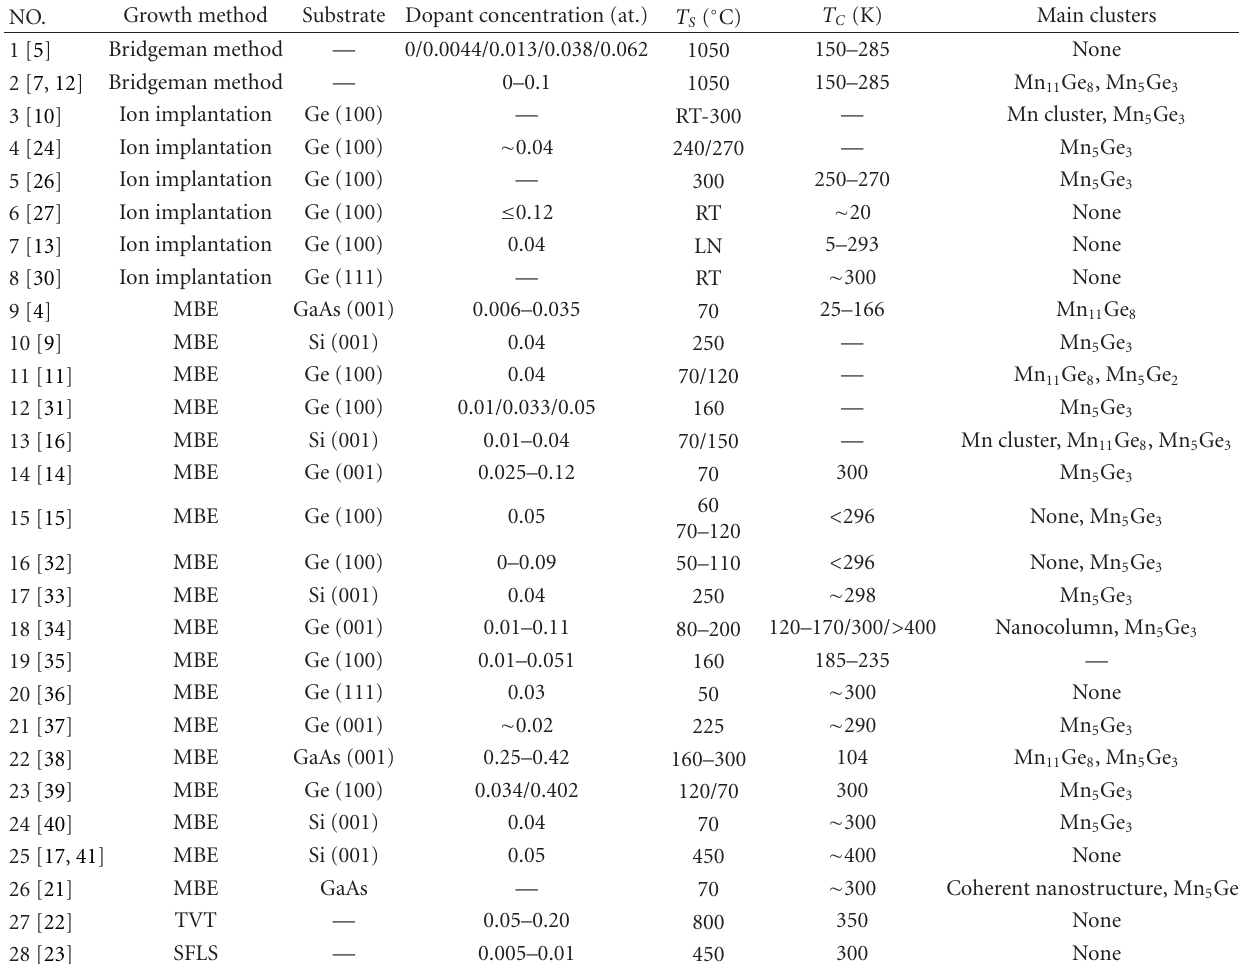
Table 1: Summary of typical Ge 1 − x Mn x obtained with various growth